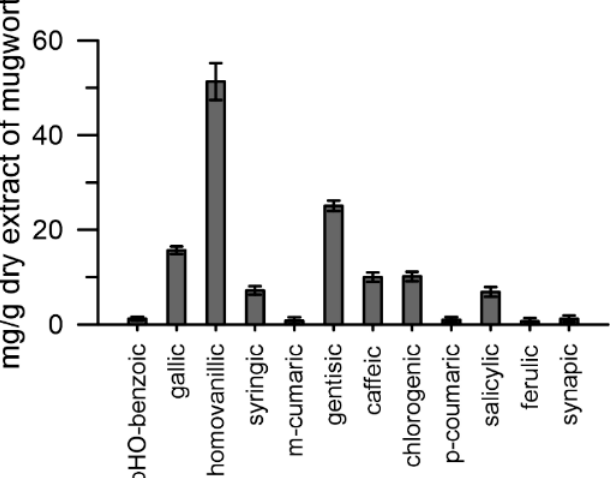
Figure 4. Phenolic acids present in the aqueous extract of mugwort. Data are expressed as means ± SEM from three independent tests.